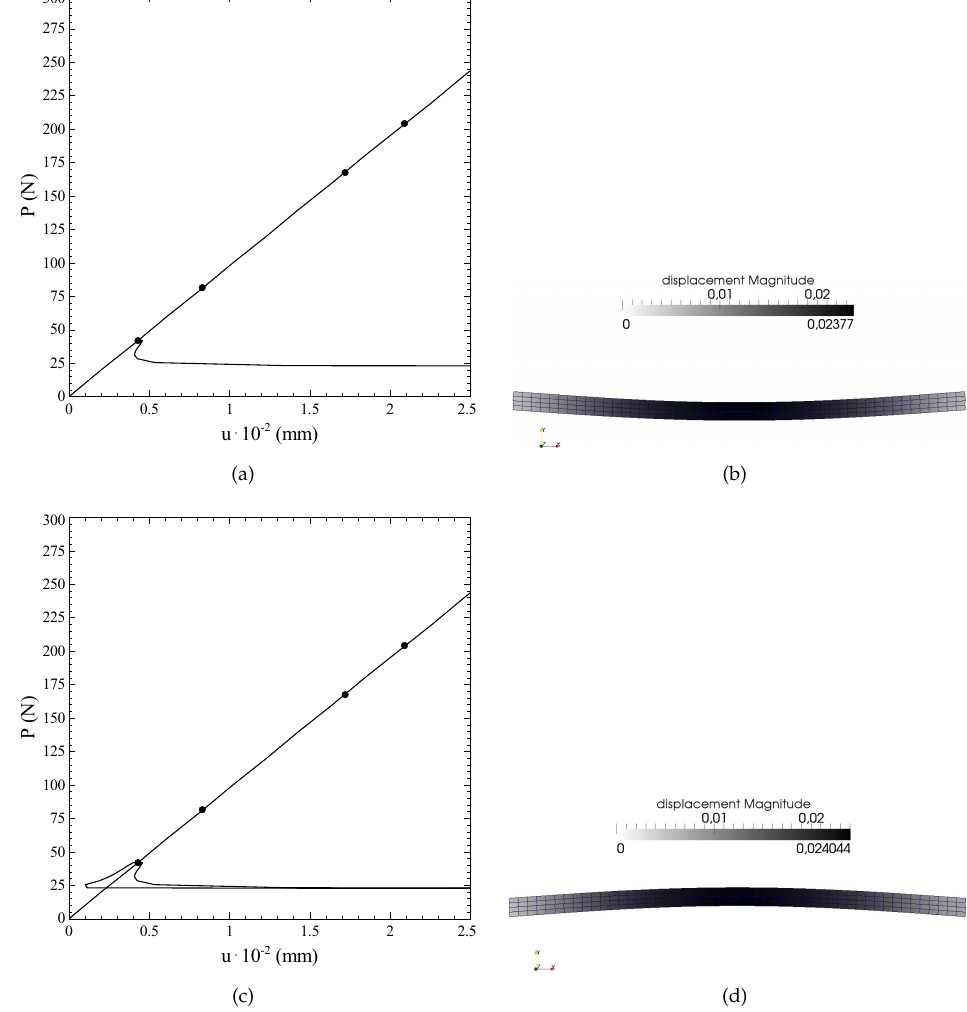
Figure 8. Computation of the first bifurcation branch: ( a ) positive side of the branch, ( b ) corresponding deformed shape, ( c ) negative side of the branch, ( d ) corresponding deformed